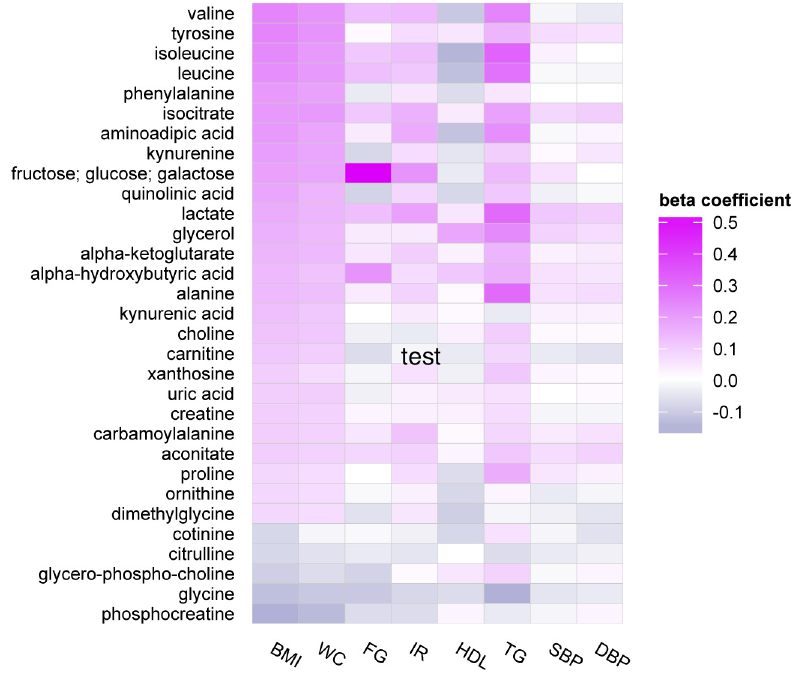
Fig 2. Heatmap of non-lipid metabolite profiles associated with metabolic